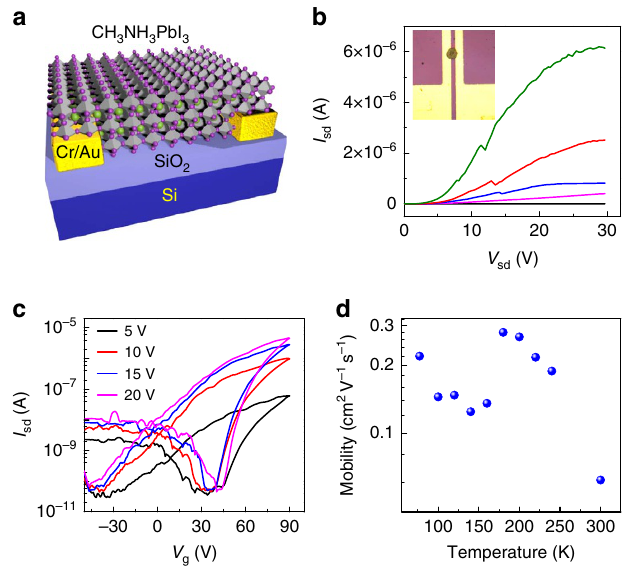
Figure 1 | Field-effect transistors based on individual perovskite microplate. ( a ) Schematic of the bottom-gate, bottom-contact halide perovskite microplate field-effect transistor fabricated on a 300-nm SiO 2 /Si substrate with 5nm Cr/50nm Au as contact. ( b , c ) The output ( V g ¼ 0, 20, 40, 60, 80V; from bottom to top; b ) and transfer ( V sd ¼ 5, 10, 15, 20V; c ) characteristics of a field-effect transistor based on a perovskite crystal microplate at 77K. The inset of b shows an optical image of a typical device. The channel length is around 8 m m. ( d ) The temperature-dependent field- effect electron mobility measured with a source-drain voltage of